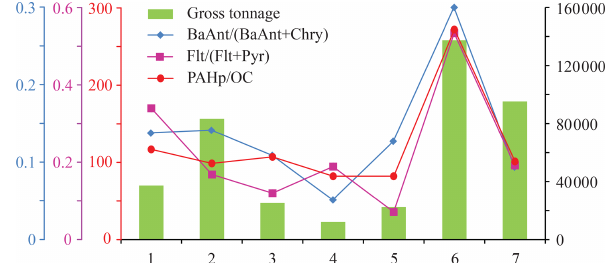
Figure 4. Correlations of the diagnostic ratios and the sum gross tonnage (dimensionless) of vessels arriving and departing the har- bour of Longyearbyen during sampling hours on the summer pe- riod P4 days when the UNIS station was downwind of the harbour ( n =